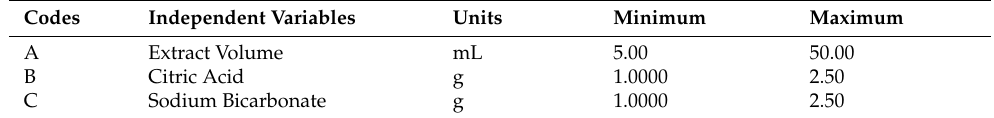
Table 8. Variable levels for preparing muffins.